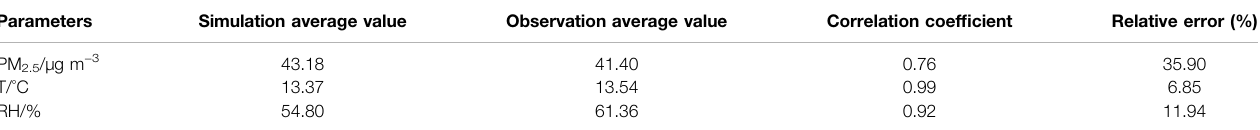
TABLE 1 | The statistical correlation between observation data and simulation results of WRF-Chem.